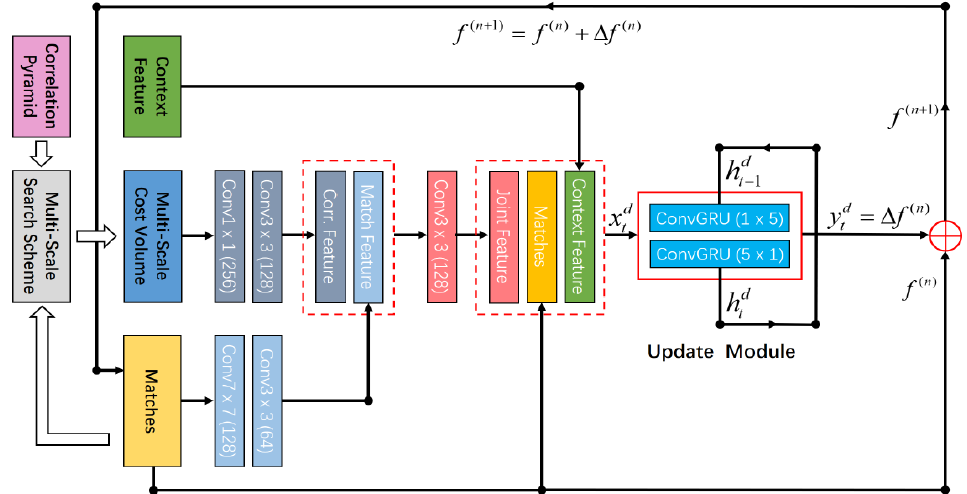
Figure 3. The overall structure of the proposed motion estimator using a deep convolution network.